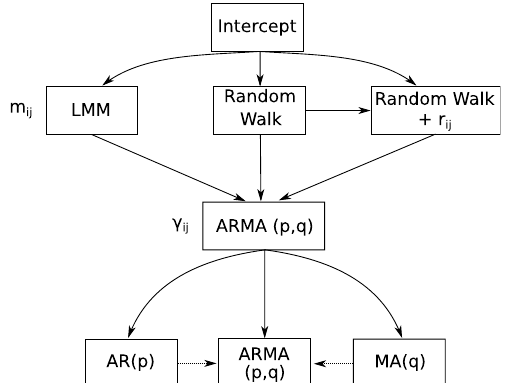
Figure 9. Stages 1 and 2 of the model selection procedure. LMM: linear mixed effect model; r ij : overdispersion parameter at observational level; ARMA( p , q ): Autoregressive moving average model of order p and q .